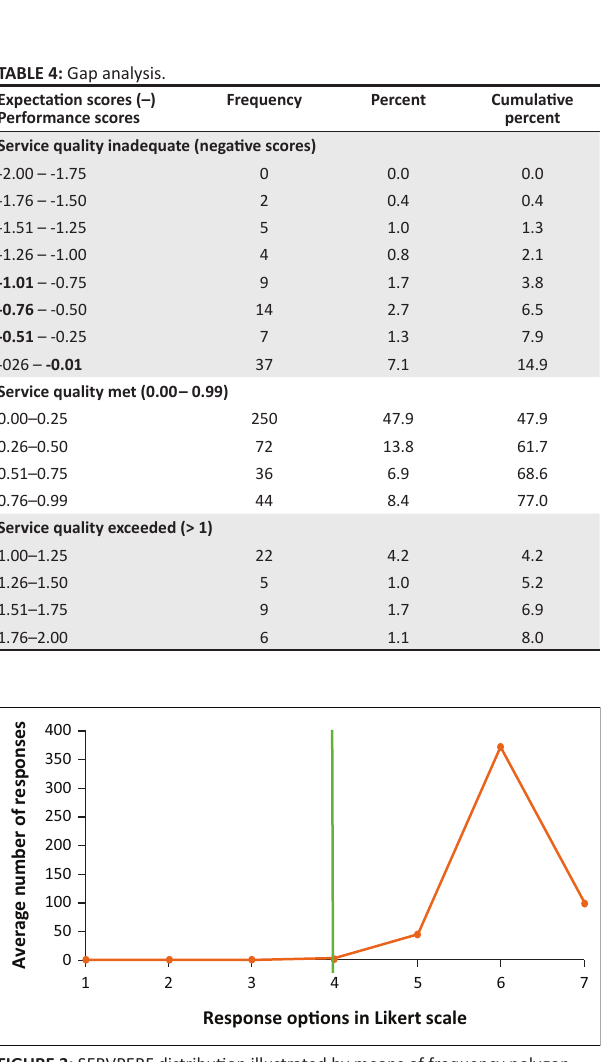
TABLE 5: Scheffe’s post-test results. Comparison groups Salary